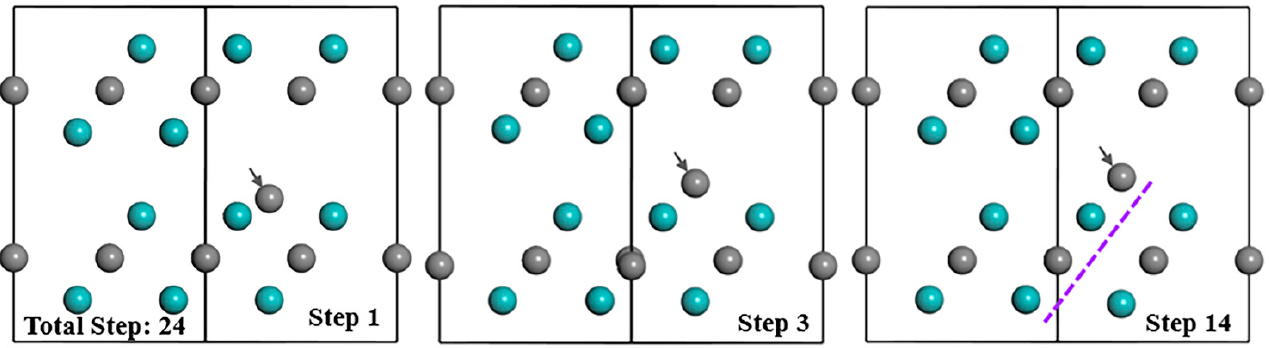
Table 4. Calculated formation energy and binding energy of Mo 2 C supercell with defect complexes (eV).